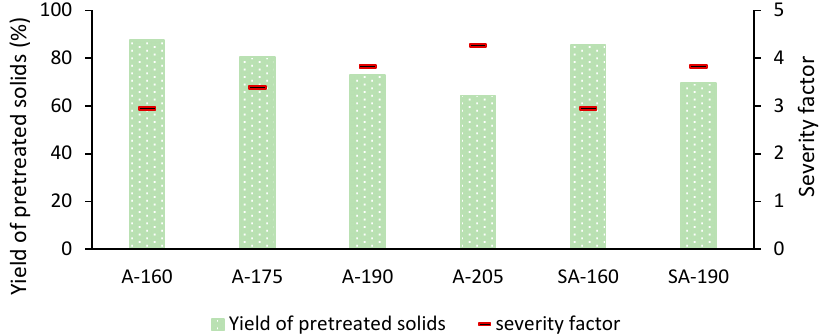
Figure 1. Gravimetric yield of pretreated solids after autocatalyzed hydrothermal pretreatment (A ‐ HTP) at 160 °C (A ‐ 160), 175 °C (A ‐ 175), 190 °C (A ‐ 190), and 205 °C (A ‐ 205), and sulfuric acid ‐ catalyzed (SA ‐ HTP) hydrothermal pretreatment at 160 °C (SA ‐ 160) and 190 °C (SA ‐ 190).